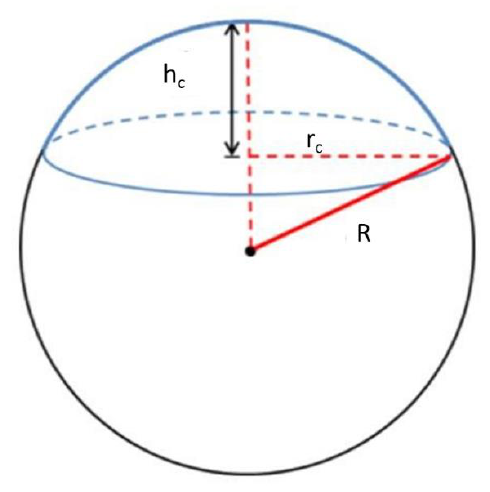
Figure A2. Representation of a spherical cap.